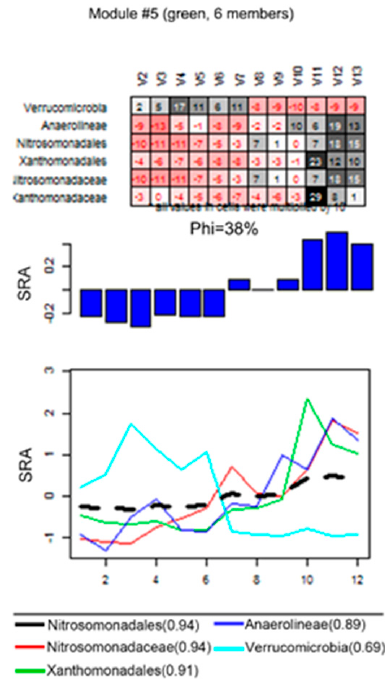
Figure 6. Conceptual example of eigengene network analysis with module 5 under control CO 2 concentration.